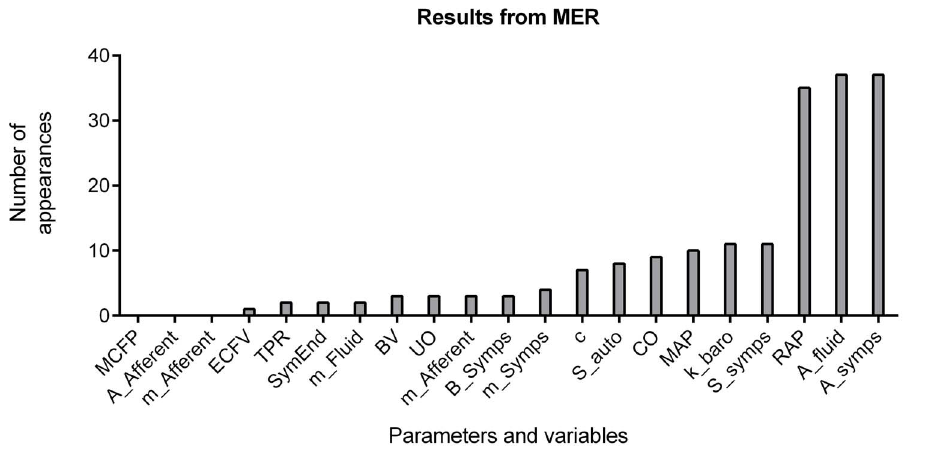
Figure 7. A comparison of the most influential factors predicting model decompensation. The 300 individuals were used to generate 37 collections of maximally effective rubrics (MER). The height of the bar represents the number of times the variable or parameter appeared in an MER.